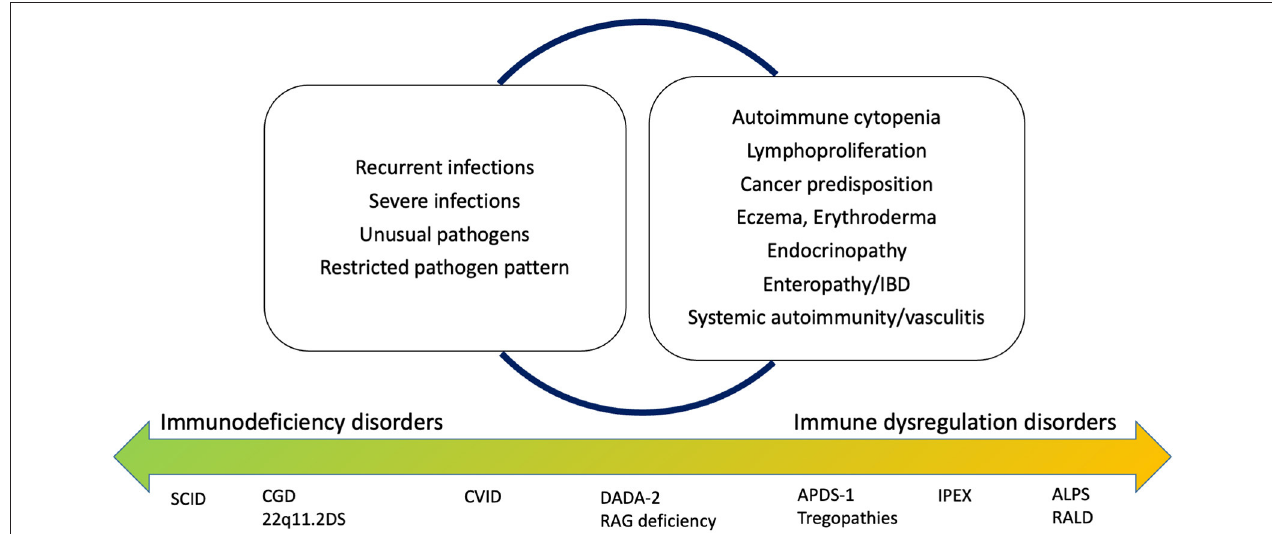
FIGURE 1 | Old and new warning signs for inborn errors of immunity. 22q11.2DS, 22q11.2 deletion syndrome; ALPS, autoimmune lymphoproliferative syndrome; APDS, Activated Phosphoinositide 3-kinase d syndrome; CGD, Chronic granulomatous disease; CVID, Common variable immunodeficiency; DADA-2, deficiency of adenosine deaminase 2; BD, inflammatory bowel disease; IPEX, immune dysregulation, polyendocrinopathy, enteropathy, X-linked stndrome; RALD, RAS-associated leukoproliferative disease; SCID, Severe combined